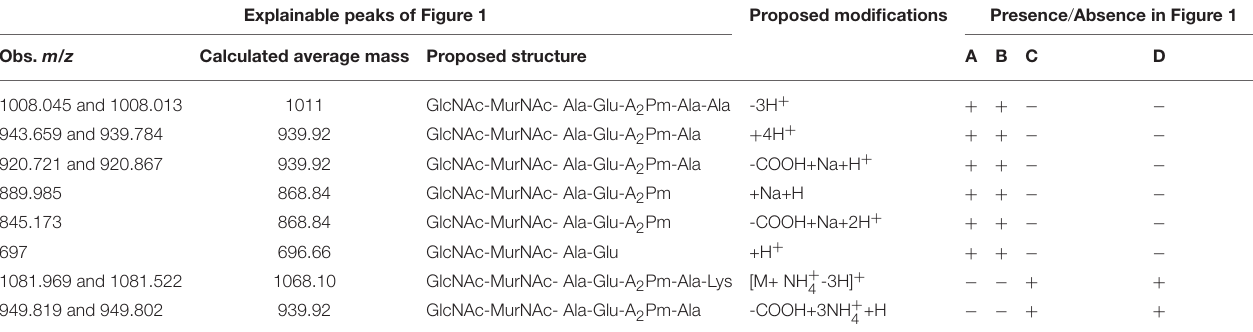
TABLE 5 | Observed and calculated average m/z ’s along with their proposed structures and proposed modifications as present in the Figure